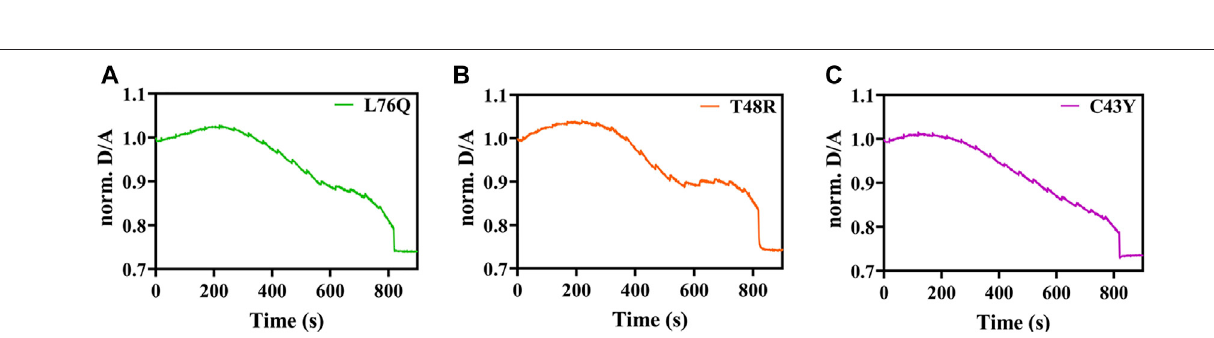
Frontiers in Molecular Biosciences |